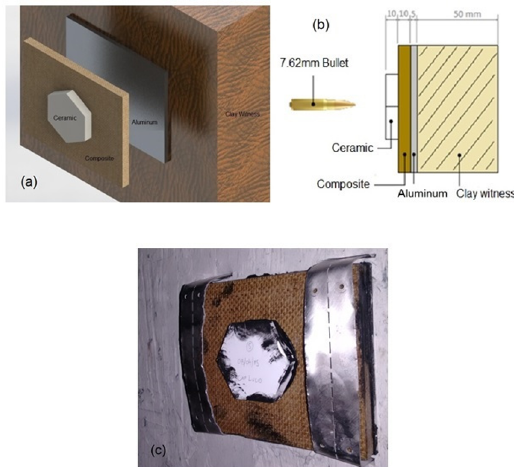
Figure 2. (a) Schematic of a complete MAS, (b) Thickness layers and (c) Actual MAS with pure mallow fabric composite as second layer. Ballistic tests were carried out at the Brazilian Army Shooting range facility, Centro de Avaliações do Exército ,